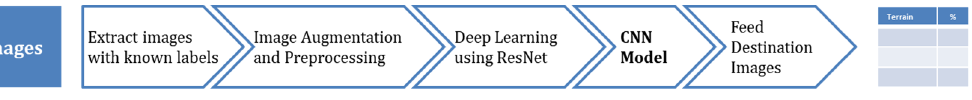
Figure 6. Big data analytics process flow of images for thematic